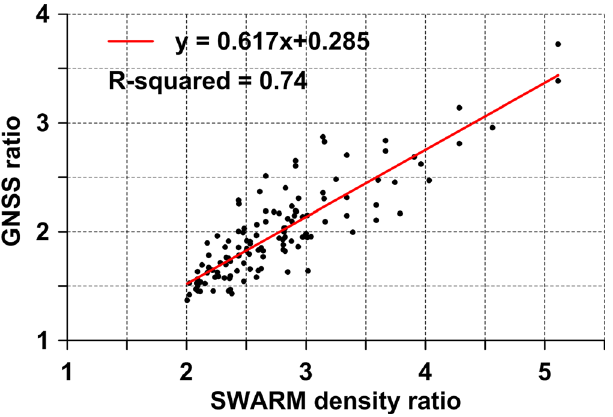
Fig. 8. The relationship between of SWARM density ratio and GNSS-derived